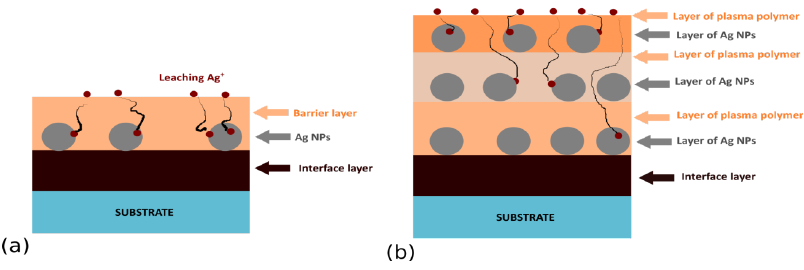
Figure 1. Common structure of ( a ) sandwich and ( b ) multi-layered Ag-based nanocomposites.